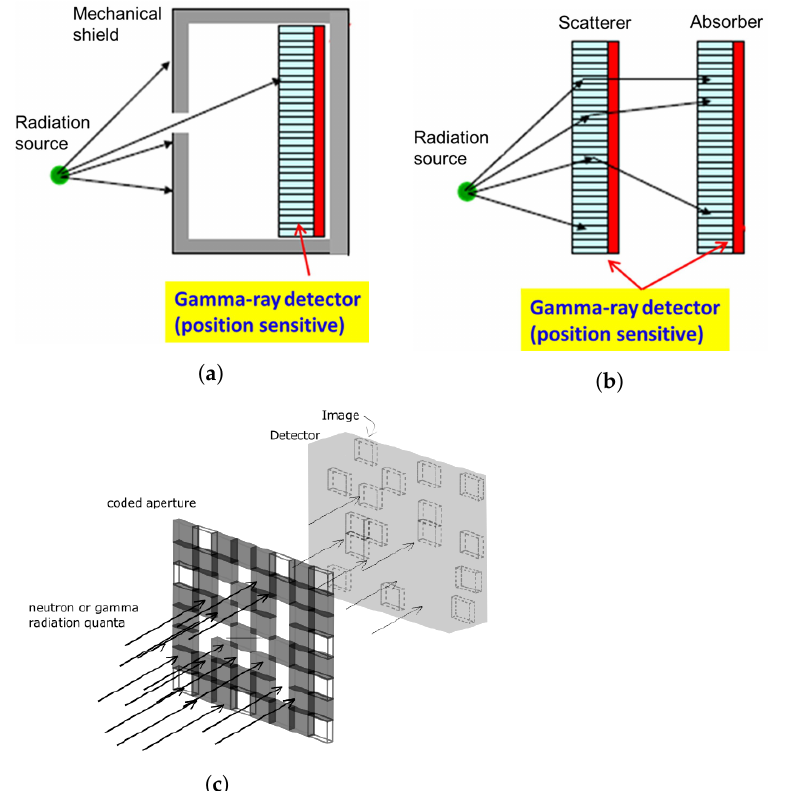
Figure 10. Basis of gamma cameras operation: ( a ) Pinhole camera with a single hole. Reproduced, with permission, from Reference [22]; copyright Elsevier (2013). ( b ) Compton camera.